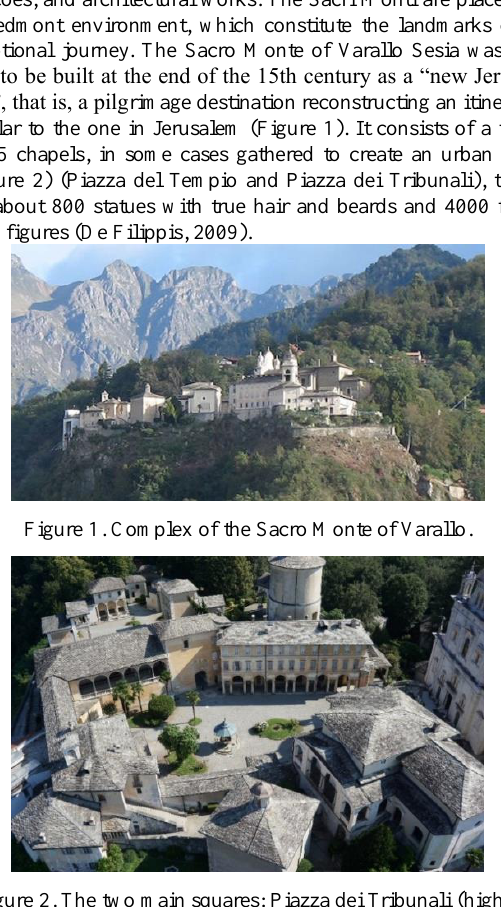
Figure 2. The two main squares: Piazza dei Tribunali (higher part of the image) and Piazza del Tempio in the